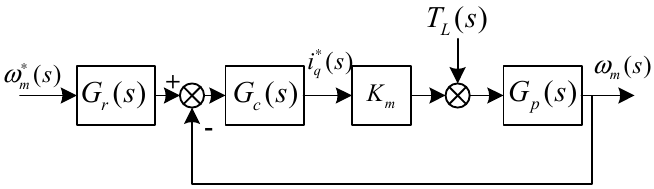
Figure 13. Block diagram of the speed–loop MADRC in the frequency domain.